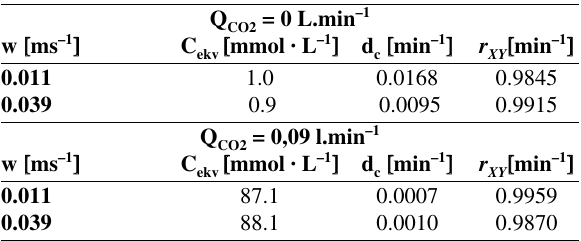
= 0.09 L · min –1 )–expe- CO2